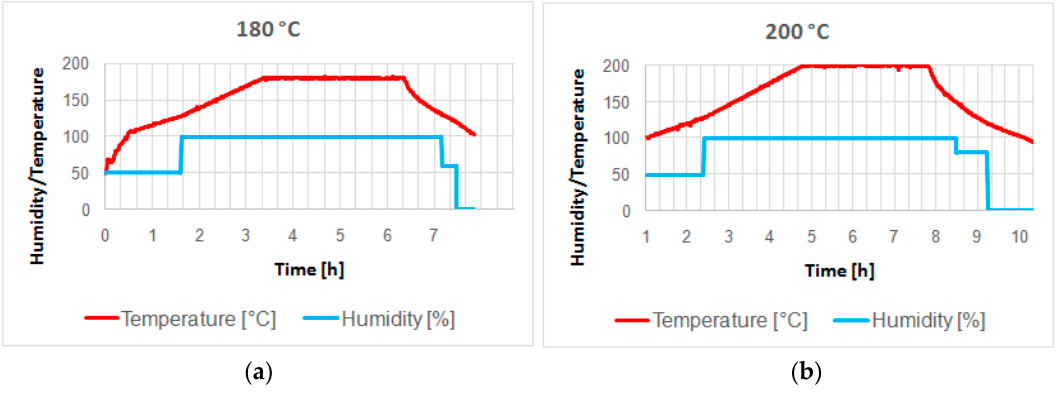
Figure 1. Temperature and humidity courses with the modifications ( a ) 180 °C; ( b ) 200 °C.